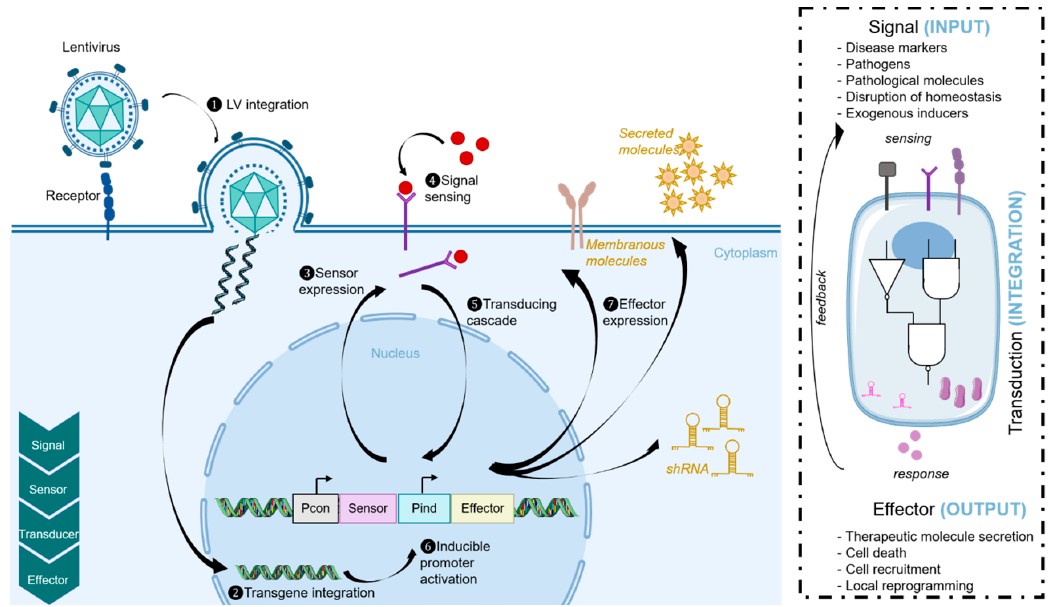
Figure 2. Synthetic biology approaches. Lentiviral vectors are used to transduce cells. These vectors encode the main parts of the synthetic network: receptors, transducers, and effectors. Inputs signals that are markers of a pathological condition will be sensed by specific membranous or intracellular receptors, inducing a transducing cascade. This signal integration will lead to the expression of effector molecules such as shRNA, cytokines, or pro-apoptotic cues.